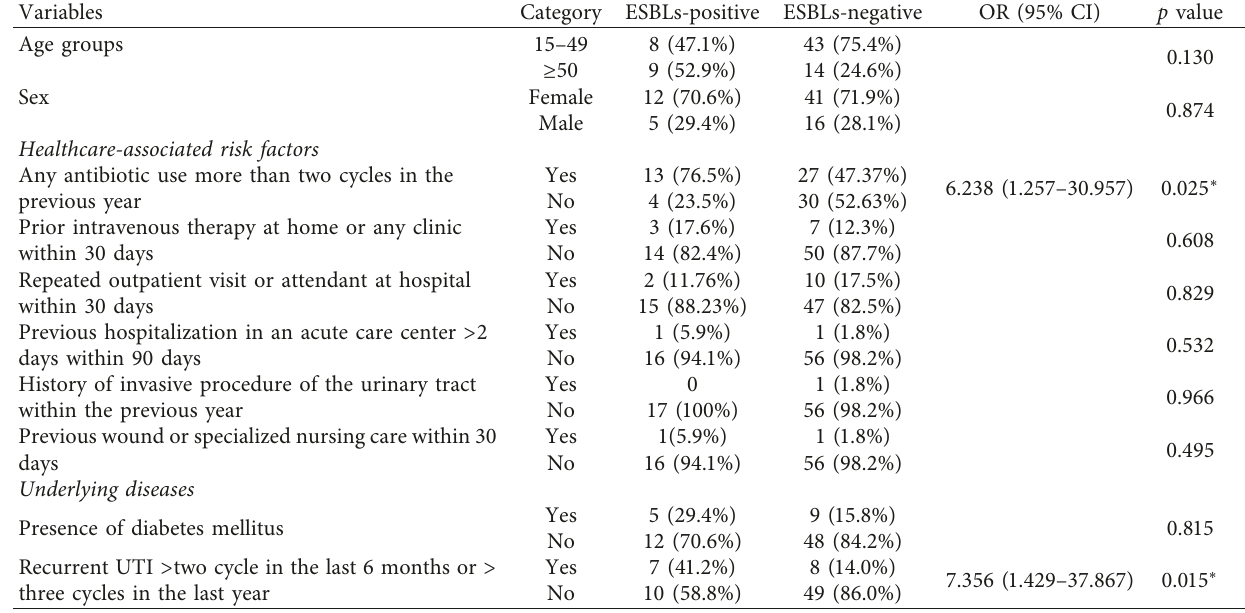
Table 2: Characteristics of patients infected with ESBLs-producing and non-ESBLs-producing E. coli and K. pneumoniae among com- munity-onset urinary tract infections in JUSH, Southwest Ethiopia, 2016.